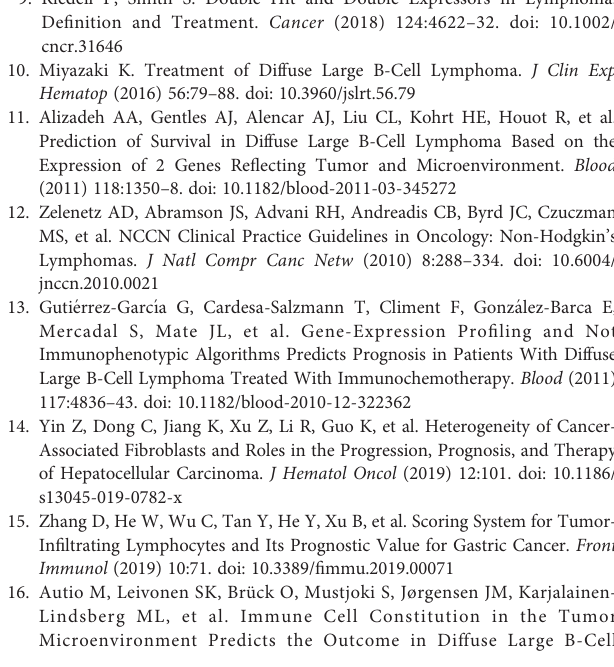
Supplementary Figure 1 | Selection of genes for constructing predicting model. (A) LASSO coef fi cient pro fi les of 24 genes. (B) Partial likelihood deviance plot. (C) Forest plot shows the multivariable Cox regression analysis of eight genes. Supplementary Figure 2 | Exploring function of HK2. (A) RT-PCR analysis showing HK2 expression stage I+II and III+IV. (B) Correlation analysis of HK2. (C) GO enrichment analysis of negative and positive correlated genes. (D) KEGG enrichment analysis of negative and positive correlated genes. Supplementary Figure 3 | Survival information of the patients between high- and low-risk group. (A) The correlation of risk score and patient numbers. (B) The correlation of risk score and survival time. Supplementary Figure 4 | Validation of prediction model in testing set. (A, B) Kaplan-Meier analysis between high and low risk group in GSE31312 and GSE10864 datasets. (C, D) ROC curve analysis of GSE31312 and GSE10864 datasets. Supplementary Figure 5 | KM survival stratifcation analyses in GSE117556 dataset. (A) MYC/BCL2 expression. (B) LDH level. Supplementary Figure 6 | Expression of immune-related genes in high and low risk group. (A, B) Boxplot showed difference of immune-related genes in high and low risk group in GSE117556 and TCGA-NCICCR dataset,